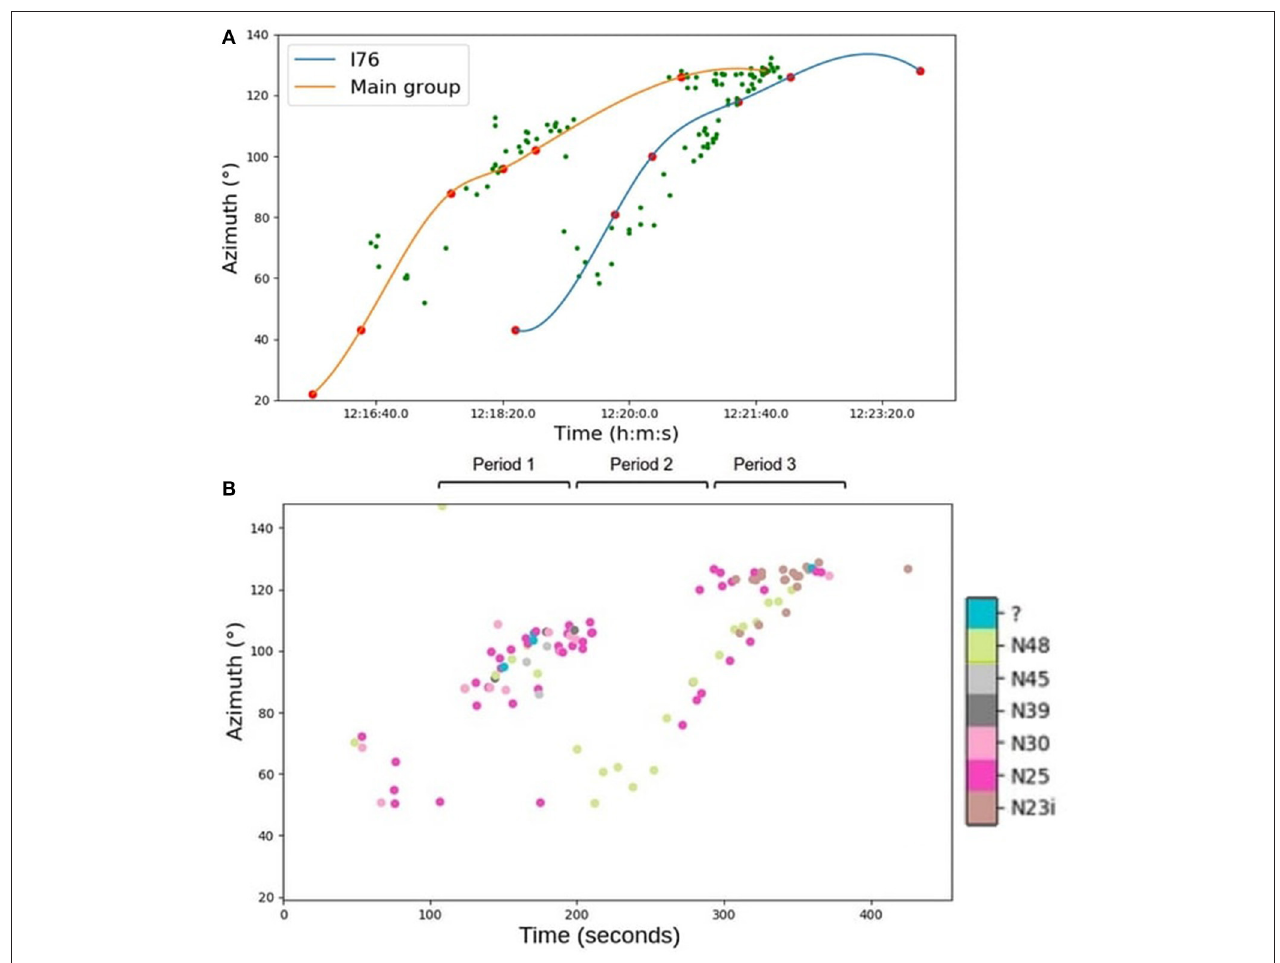
FIGURE 12 | (A) Graph of the passage of the 31st of August. Each green point represents a vocalization placed in azimuth. The blue curve is the interpolated position of the male I76 visually detected, the orange curve is the large group. (B) Graph of the passage of the 31st of August. Each point represents a vocalization placed in azimuth. Each color represents a type of call. The most common types are N25, N48, and N23i. The track was split into three 80-s